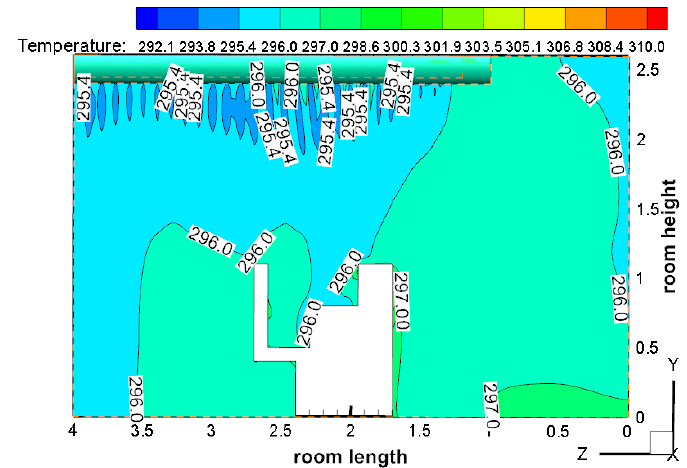
Figure 8. The temperature distribution of the X = 2 m section.